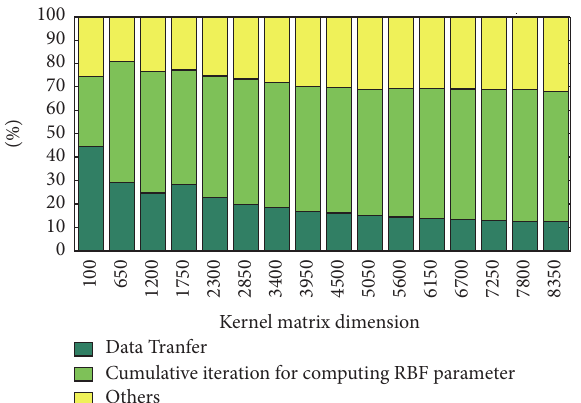
Figure 3: Breakdown of elapsed time for RBF parameter computa- tion on